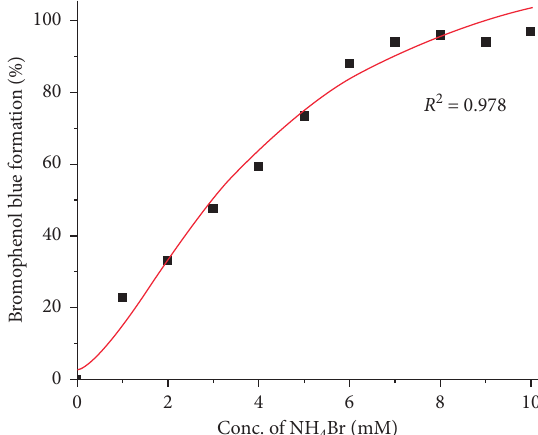
Figure 22: Effect of different concentrations of NH � 0, 2 � 2, ... , 10 � 10mM) on the rate of formation of bromophenol blue after 10 4 Br (1 minutes. Reaction conditions are as follows: 10ml of 1.0mM phenol red in water+10ml of 10.0mM NH 4 Br in water+0.5g of cata- lyst+2.5mM H 2 O 2 , in a round-bottomed flask. T � 298K and P �